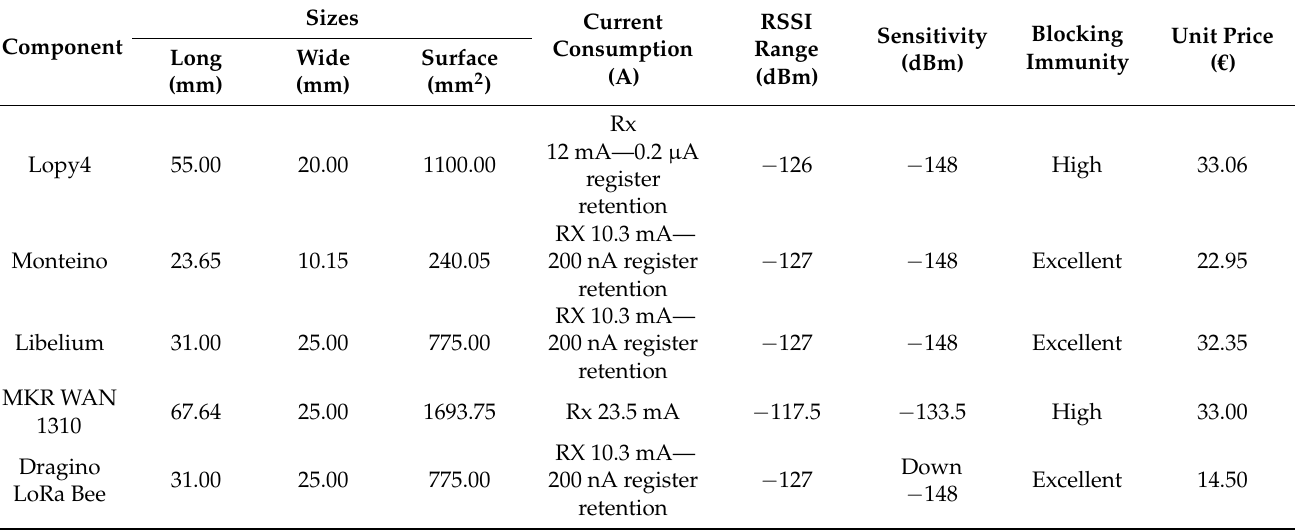
Table 3. LoRa components comparison.